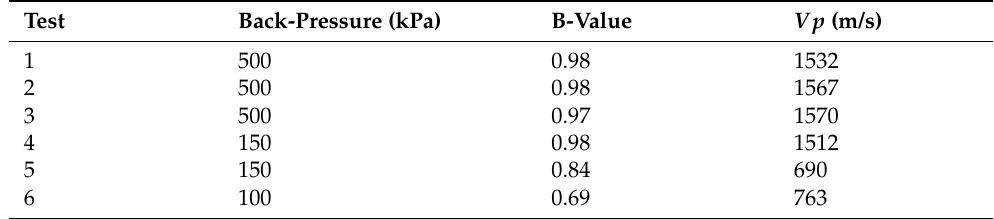
Table 4. Final values obtained for each specimen after the saturation